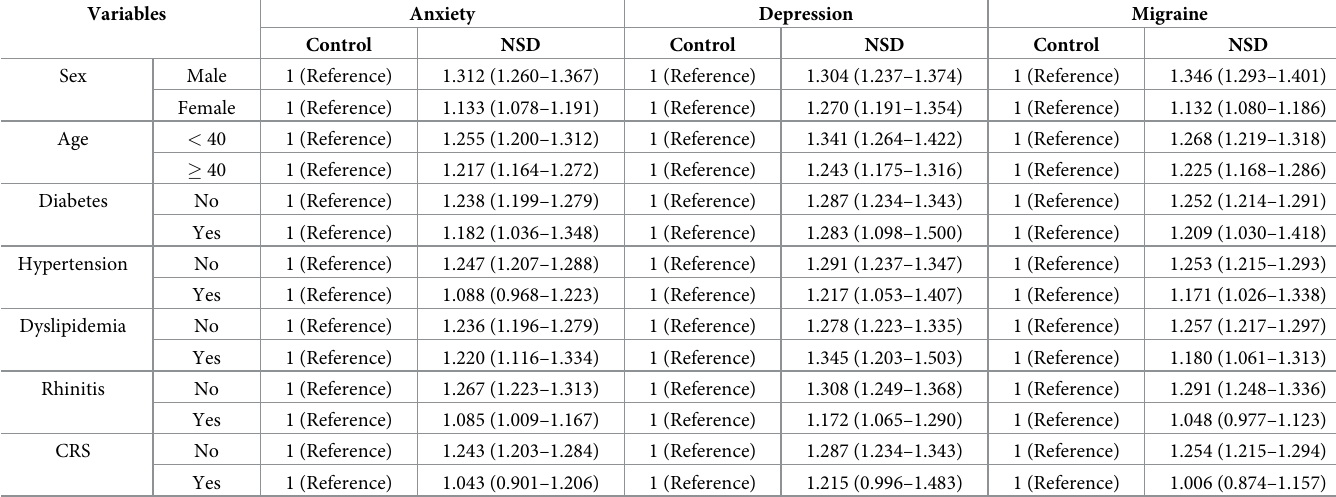
Data are expressed as hazard ratio (95% confidence interval). Model 1 was non-adjusted; Model 2 was adjusted by age and sex; Model 3 was adjusted by age, sex, income level, diabetes, hypertension, and dyslipidemia; and Model 4: adjusted by age, sex, income level, diabetes, hypertension, dyslipidemia, rhinitis, and chronic rhinosinusitis. Abbreviations: NSD, nasal septal deviation; CRS, chronic